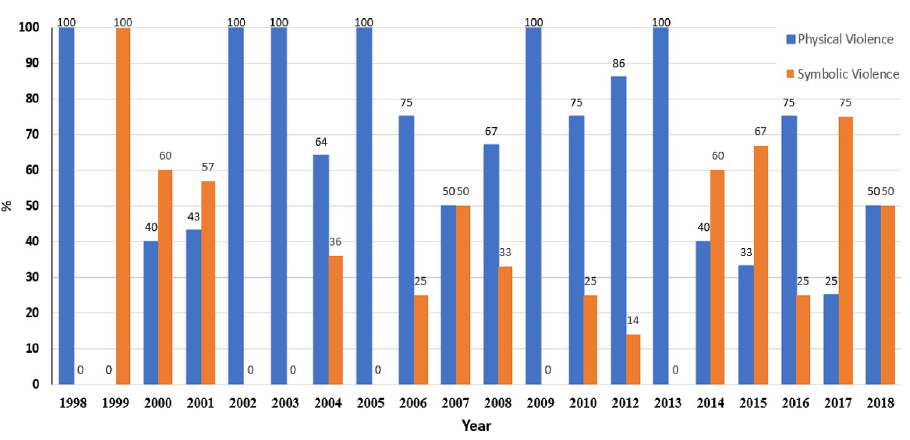
Fig 2. Distribution of physical and symbolic violent acts (in %) from 1998 to 2018 in 36 NBA games.